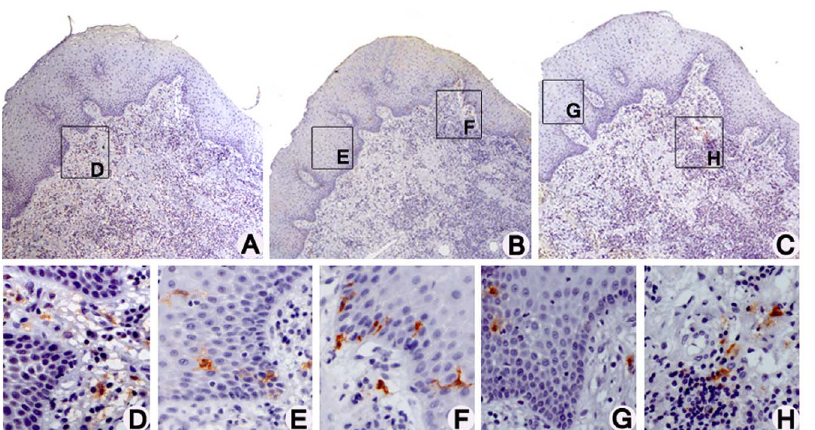
Figure 2. Regions of the gingival tissue evaluated for immature and mature DCs. Immunohistochemical staining of Factor XIIIa + immature DCs (A), CD1a + immature DCs (B), and CD83 + mature DCs (C) (streptavidin-biotin, 50x original magnification). Factor XIIIa + immature DCs could be observed in the lamina propria (LP) region (D). CD1a + immature DCs could be observed in the oral epithelium (E), sulcular epithelium and LP regions (F). CD83 + mature DCs could be observed in the oral epithelium (G) and LP regions (H) (streptavidin-biotin, 400x original magnification).